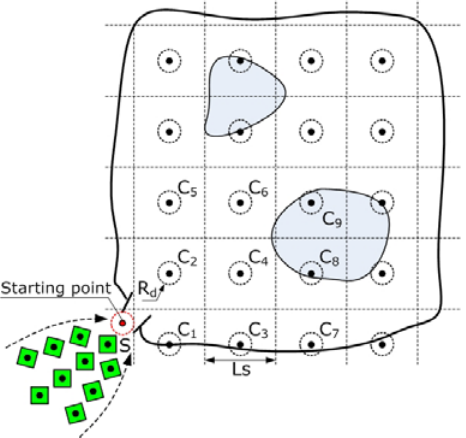
Figure 15. The principle of autonomous deployment of mobile sensor